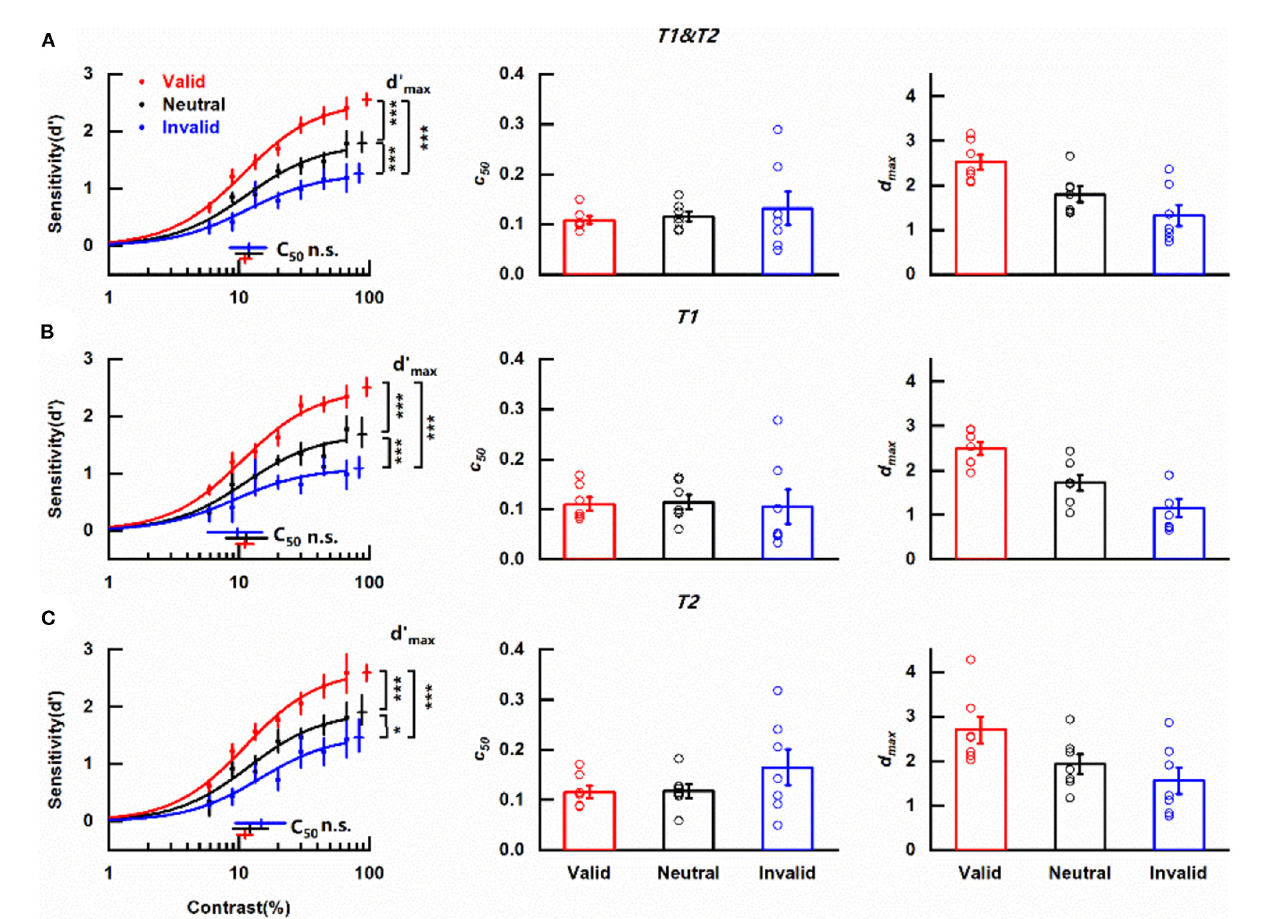
FIGURE3 Effects of cue-induced temporal attention on contrast sensitivity (A) Left column: contrast response functions for different pre-cueing conditions. Data were collapsed across the reported targets. Each data point denotes the mean across observers under the corresponding pre-cueing condition. Red, blue, and black symbols and lines indicate valid, invalid, and neutral pre-cues respectively. Error bars on data points represent within-subject standard errors of the mean, after the removal of the between-subject variability (Cousineau, 2005; Morey, 2008; Franz and Loftus, 2012; Baguley, 2013). Error bars on parameter estimates are 90% confidence intervals, obtained by bootstrapping. Middle column: parameter estimates of threshold c 50 for trials with different pre-cues for each participant. Open symbols denote parameter estimates of fitting curves of individual subjects. The bars indicate the means of the parameter estimates across the subjects under corresponding conditions. Error bars represent standard errors of the mean. Right column: same as the middle column but for parameter estimates of asymptote performance d max . * p < 0.05, *** p < 0.001. (B) Same as (A) , but only including the trials in which the reported target was T1. (C) Same as (A) , but only including the trials in which the reported target was T2.